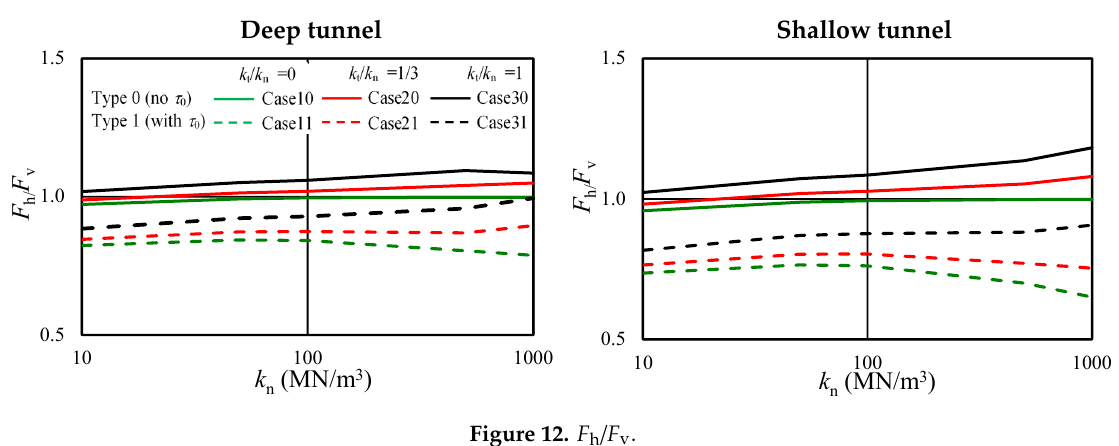
Figure 11. Maximum axial force (kN/m).